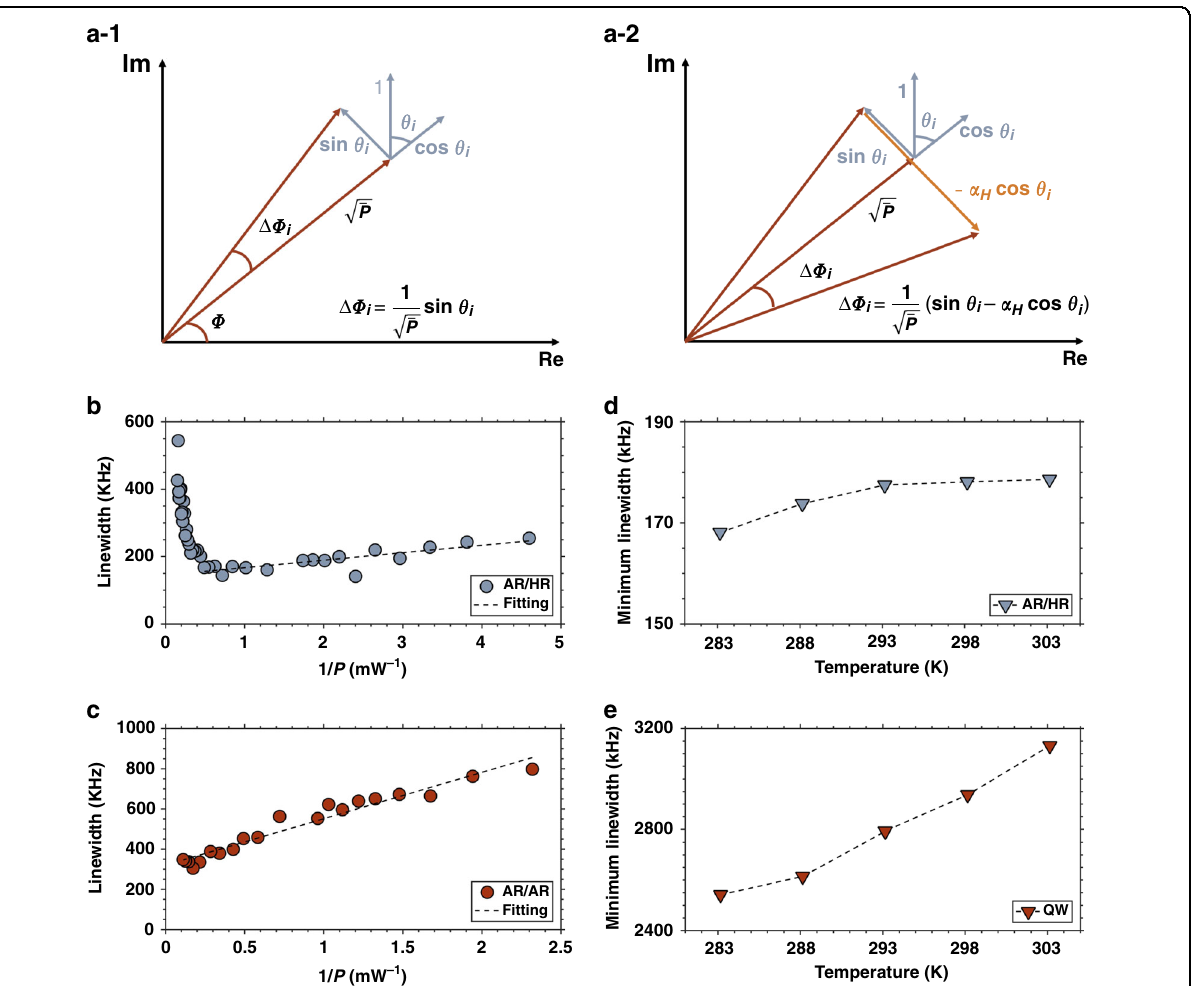
Fig. 2 Schematic illustrating the phase diffusion ( Δ ϕ i ) of the lasing fi eld with (a-1) direct action of the spontaneous emission events only; (a-2) Joint action of both spontaneous emission events and phase-amplitude coupling. The angle θ i is random. The amplitude and the phase ffiffiffi p of the lasing fi eld are denoted ( P ) and ( ϕ ) respectively. The corresponding phase change for each case is indicated by the relationship. Spectral linewidth fi tted with a pseudo-Voigt pro fi le versus reciprocal output power ( 1/P ) for ( b ) AR/HR QD DFB laser and ( c ) AR/AR QD DFB laser. The dashed lines are linear fi tting of the data. The minimum linewidth versus temperature for ( d ) AR/HR QD DFB laser and ( e ) a commercial QW DFB